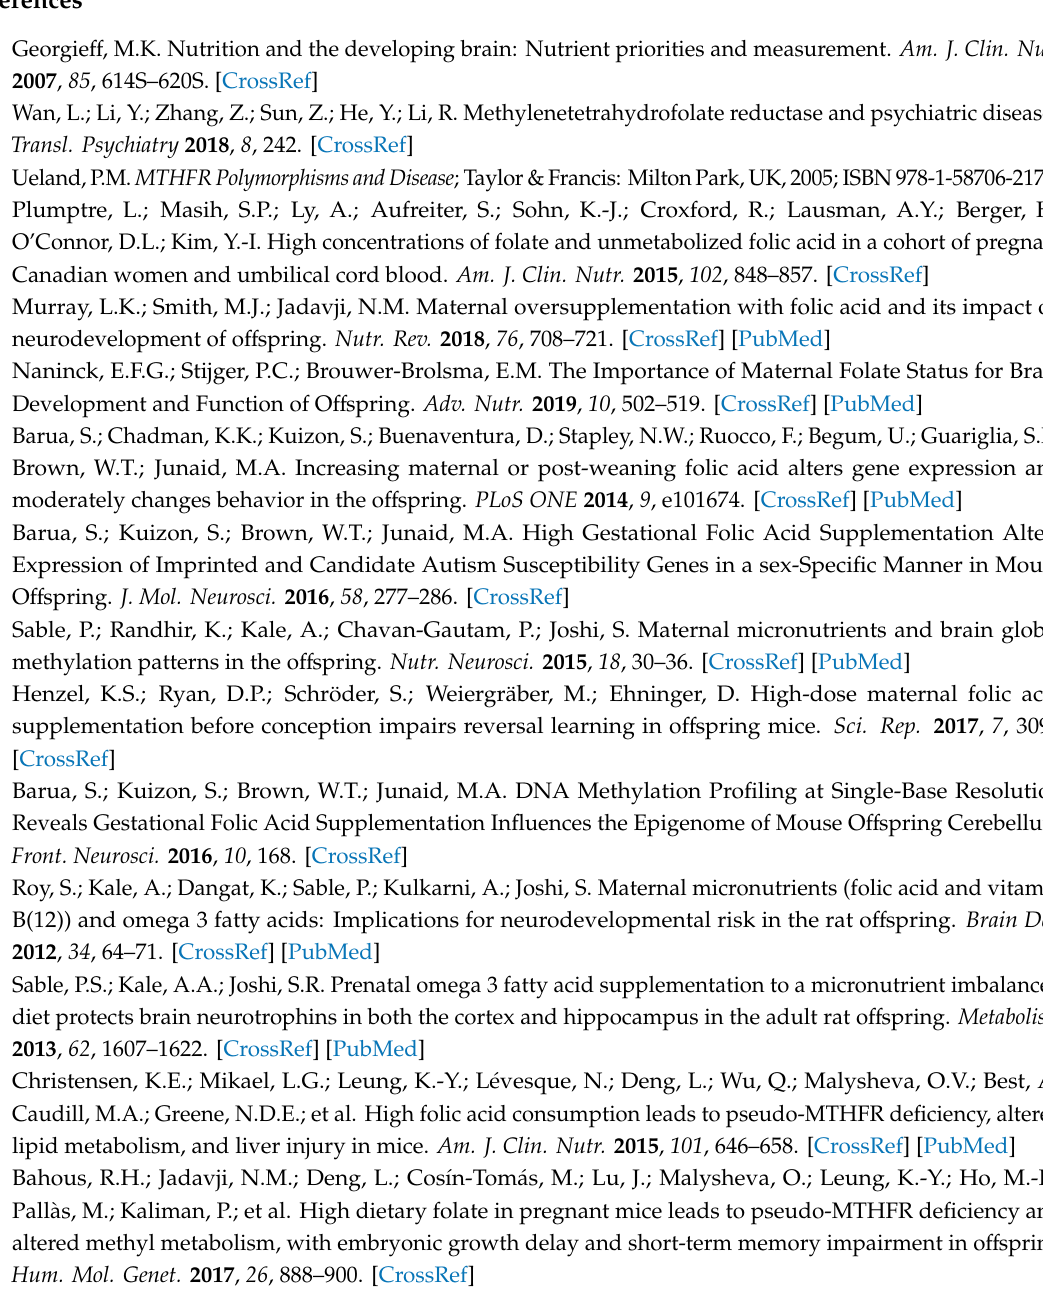
Figure S1: Social reciprocal interaction test and grip strength measurements in male and female o ff spring at pd 25 and pd 27, respectively; Figure S2: Concentrations of choline-derived metabolites and SAH measured by LC-MS in o ff spring liver; Figure S3: Phosphatidylcholine (PtdCho) and sphingomyelin (SM) measured by MALDI-IMS in o ff spring cerebellum; Table S1: Composition of Control Diet (CD) and Folic Acid